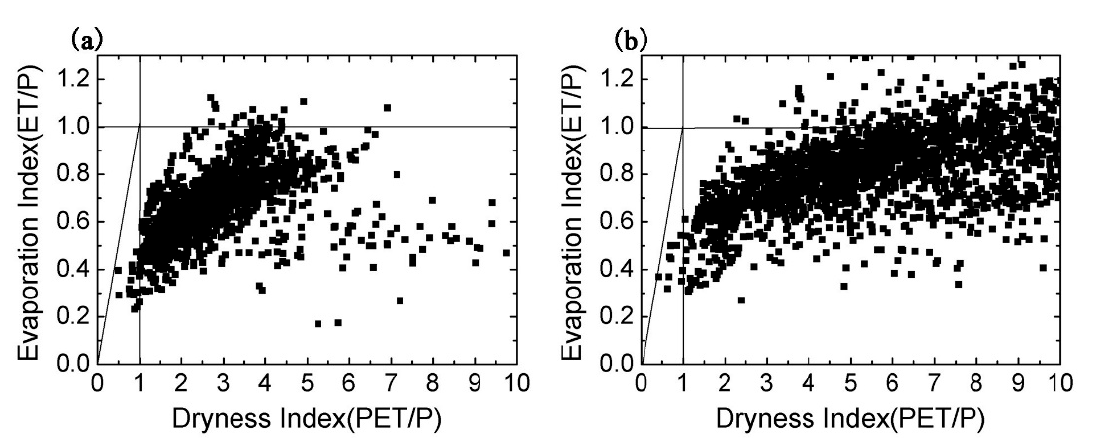
Figure 5. Scatters from the energy-control ( a ) and water-control ( b ) regions on the Budyko curve. The closer the scatter slope is to 1:1, the more PET (potential evaporation) is converted to evaporation, and the wetter the climate is.